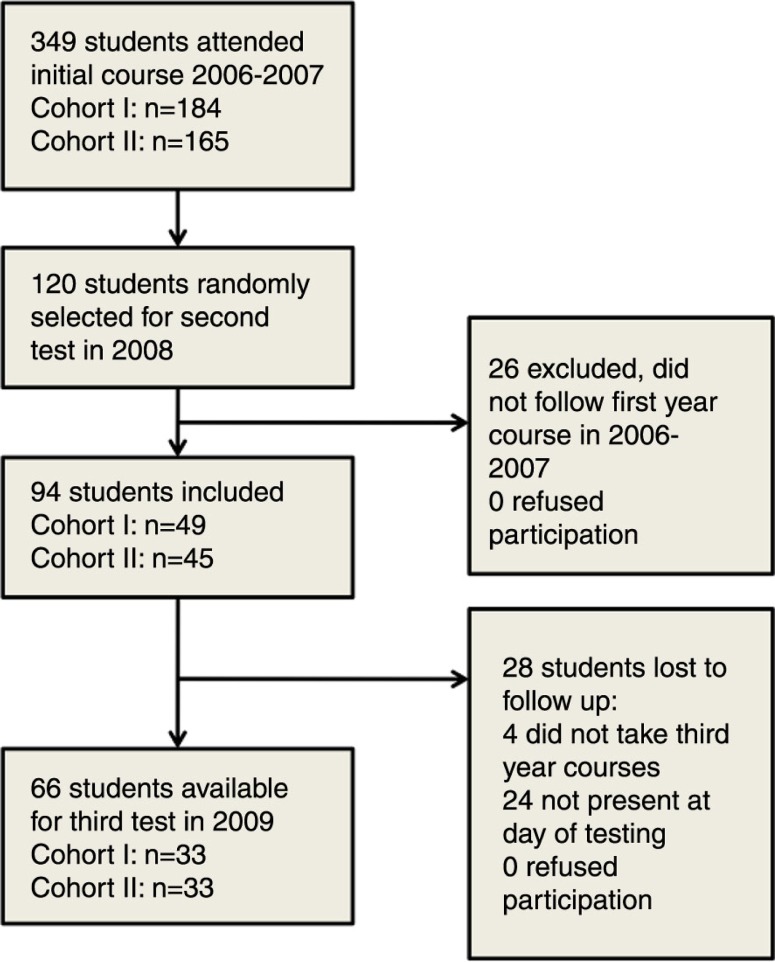
Study flow-chart.